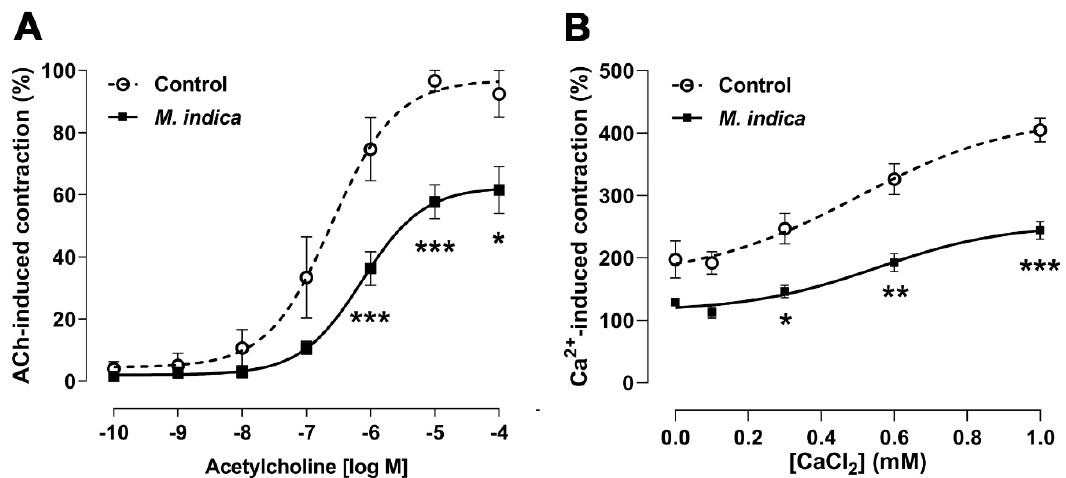
Figure 4. Antispasmodic activity of lyophilized extract of M. indica (MIE) reduces contractile response to acetylcholine (ACh). Rat ileum muscle tissue was pre-incubated with MIE (100 µ g / mL) for 20 min before contraction with ACh ( A ) and pre-incubation with MIE 100 µ g / mL reduced the influx of extracellular calcium ( B ). In both panels, control represents the contractile response of an ileal segment without pre-incubation with MIE (100 µ g / mL). Each point represents the mean of maximal response in percentage ± SEM of three experiments ( n = 3). * p < 0.05; ** p < 0.01; *** p < 0.001 vs. control.